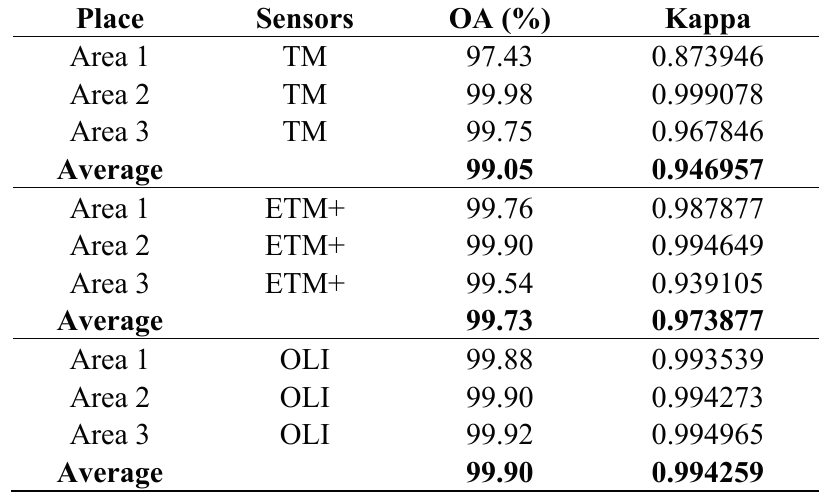
Table 2. Water body classification comparison of three Landsat sensors.